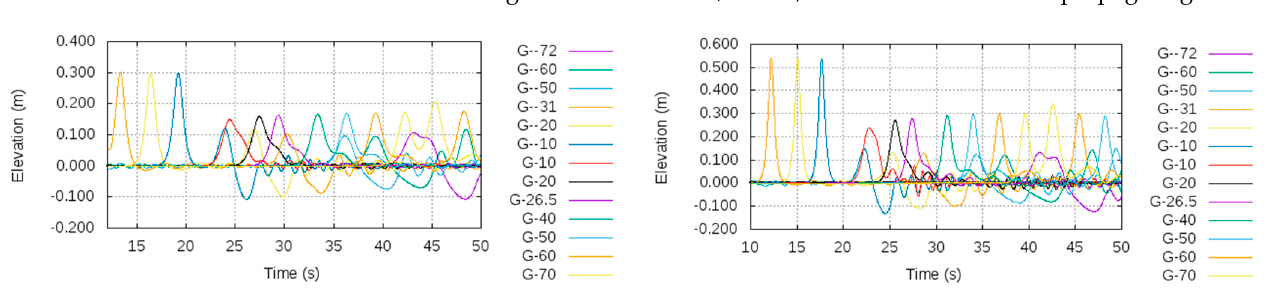
wave is not calculated. To perform the calculation, soliton amplitudes are recorded from